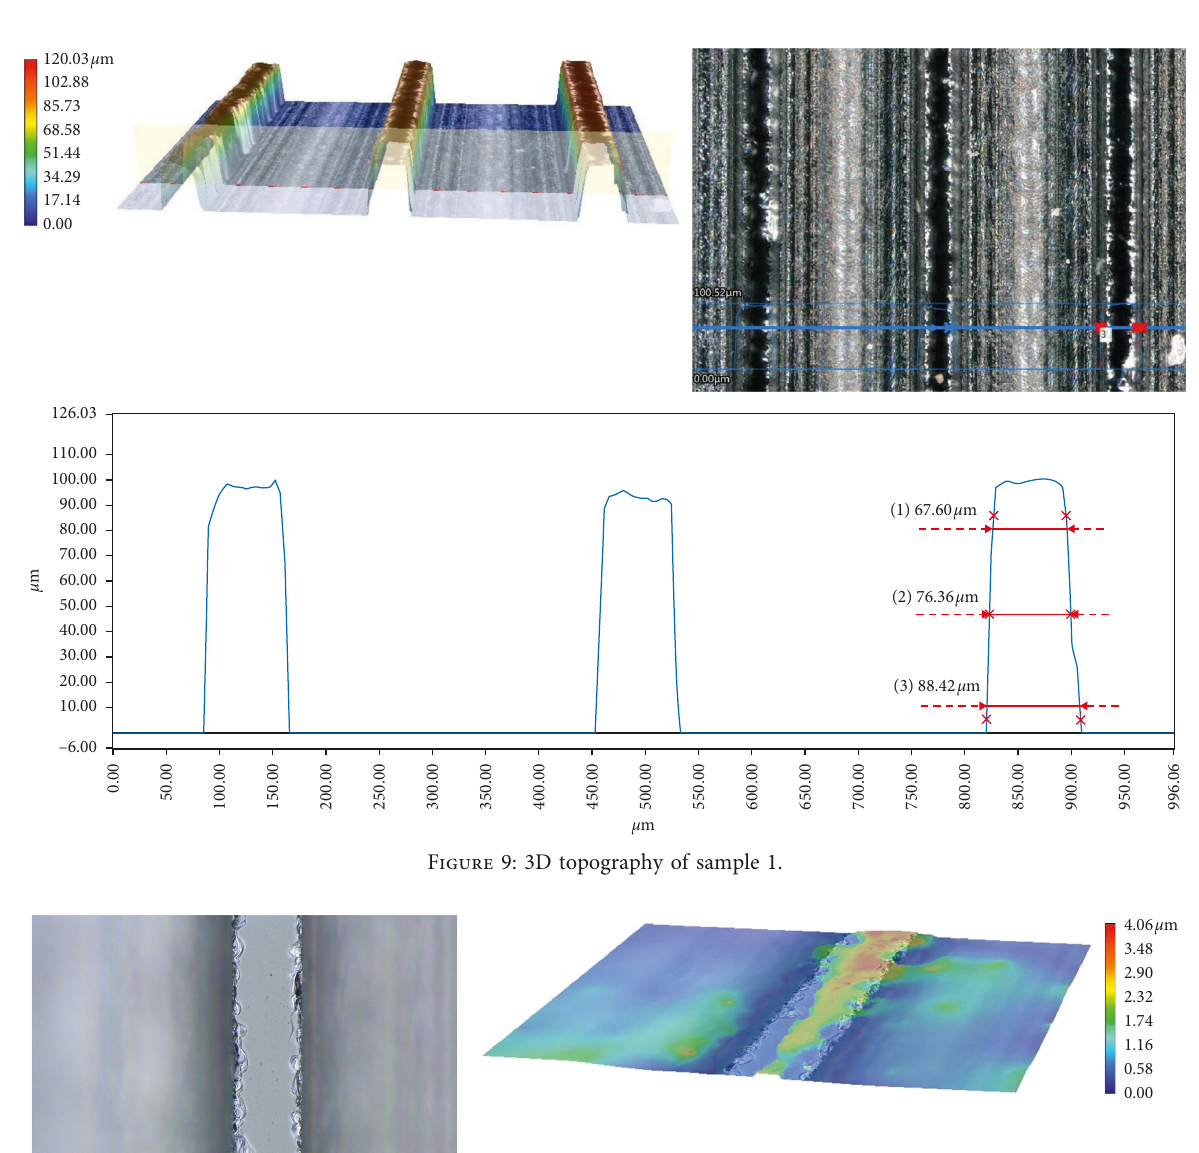
Figure 10: Microstructure topography of convex for sample 1: (a) microtopography of the convex surface at 1000 times; (b) three- dimensional diagram of (a).